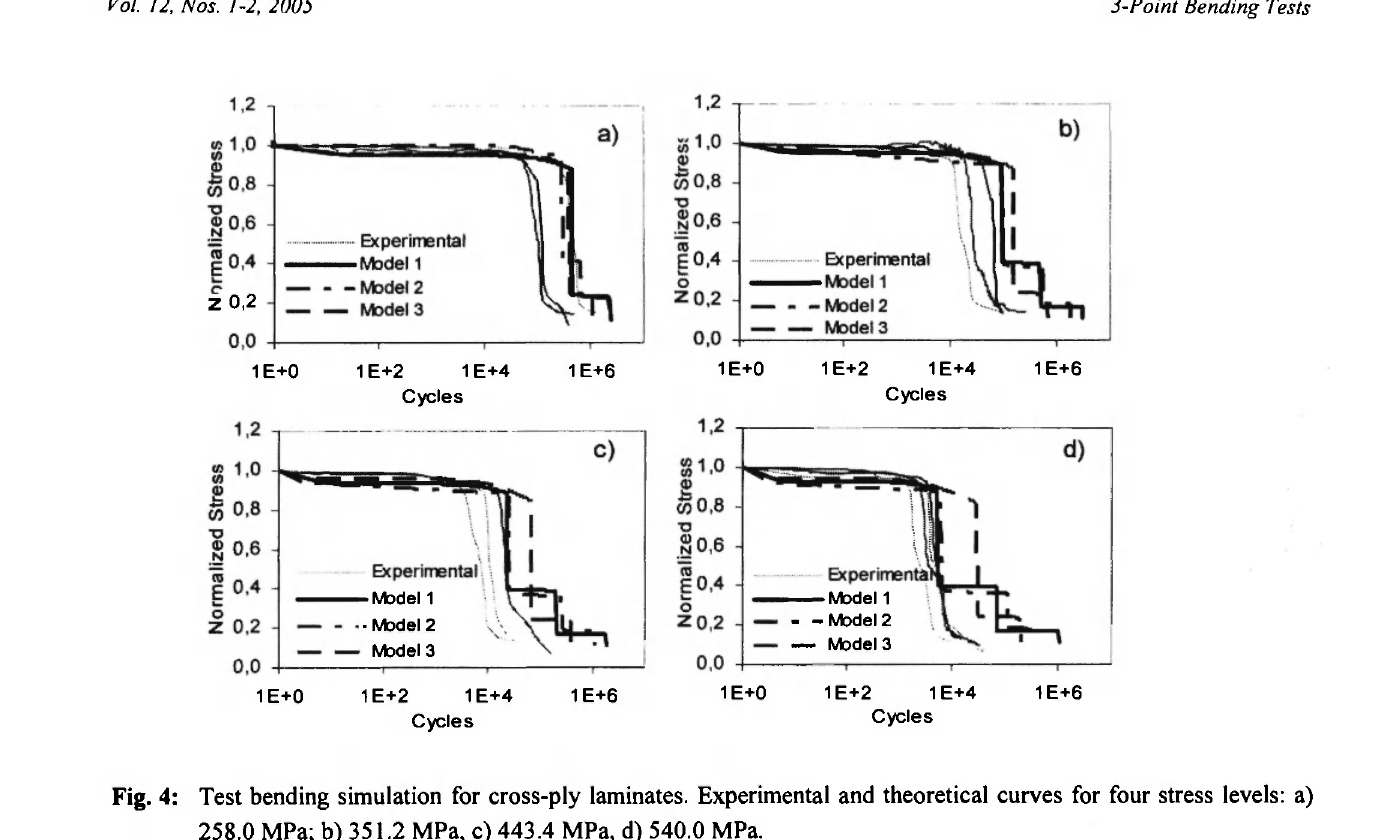
Fig. 4: Test bending simulation for cross-ply laminates. Experimental and theoretical curves for four stress levels: a) 258.0 MPa; b) 351.2 MPa, c) 443.4 MPa, d) 540.0 MPa.